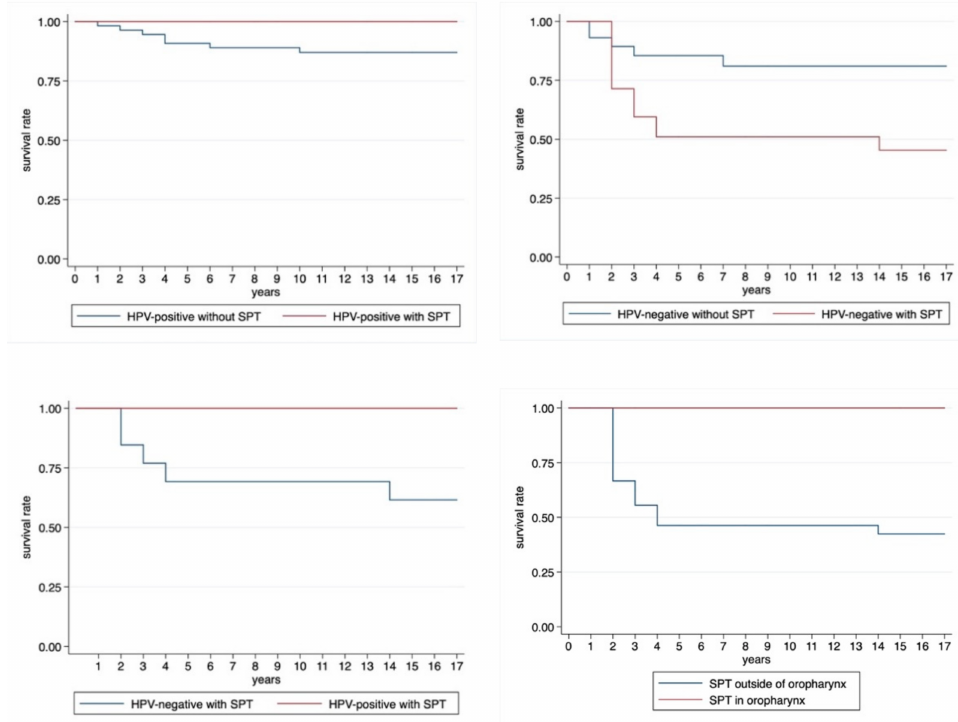
Figure 3. Kaplan–Meier survival plots of HPV-positive patients with and without SPT. (Log-rank test: p -value = 0.514), Kaplan–Meier survival plot of HPV-negative patients with and without SPT (Log-rank test: p -value = 0.033), of HPV-negative and HPV-positive patients with SPT (Log-rank test: p -value = 0.054), and of patients with SPT in and outside the oropharynx (Log-rank test: p -value = 0.054). Table 6. Multivariate Cox regression for death in association with OPSCC. Table 6 shows the influence of the following variables on death due to OPSCC and/or SPT after OPSCC: tumor HPV positivity (negative = 0, positive = 1), smoking status (0 = <10 py, 1 = ≥ 10 py), alcohol status (0 = no alcohol abuse, 1 = alcohol abuse), age (in years), SPT development (0= no SPT, 1 = SPT), therapy mode (1 = surgery, 2 = RT, 3 = surgery + RT, 4 = surgery + RT + chemotherapy, 5 = surgery + chemotherapy), and UICC stage of the index OPSCC (1 = stage I, 2 = stage II, 3 = stage III, 4 = stage IVa, 5 = stage IVb). Abbreviations: CI = confidence interval, HR = hazard ratio, py = pack years, RT = radiotherapy. Multivariate Cox Regression for Death Associated with Death Associated with OPSCC